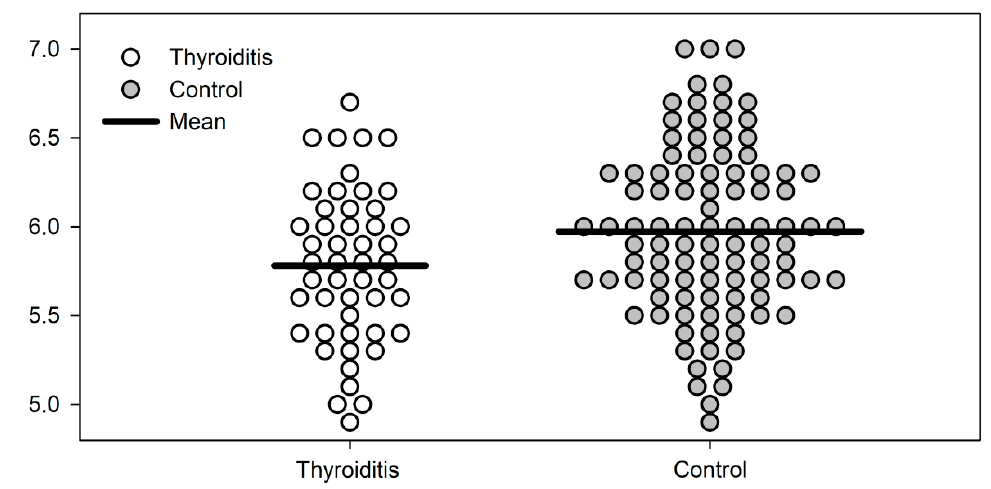
Figure 2. Dot density plot of phase angle score in the Hashimoto’s thyroiditis and control groups.